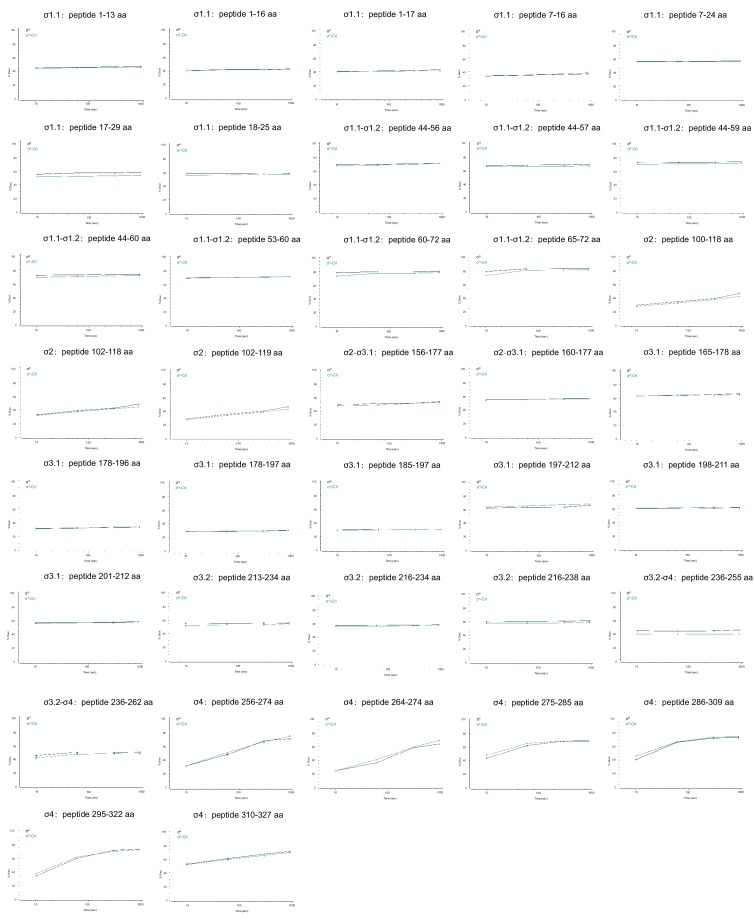
Deuterium uptake plots for additional peptides from σS whose HDX rate did not change in the presence of Crl.The deuterium uptake data are plotted as percent deuterium uptake versus time on a logarithmic scale.